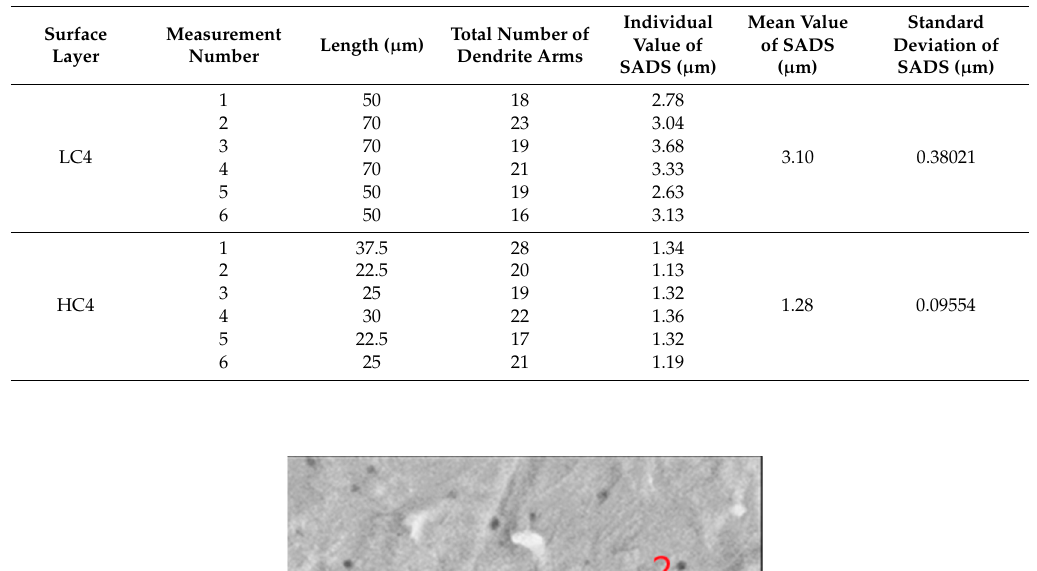
Table 5. Results of determination of the secondary dendrite arm spacing (SDAS) for the comparative stringerbeadsLC4andHC4producedatthesameprocessparameters(scanningspeed250mm / min, laser